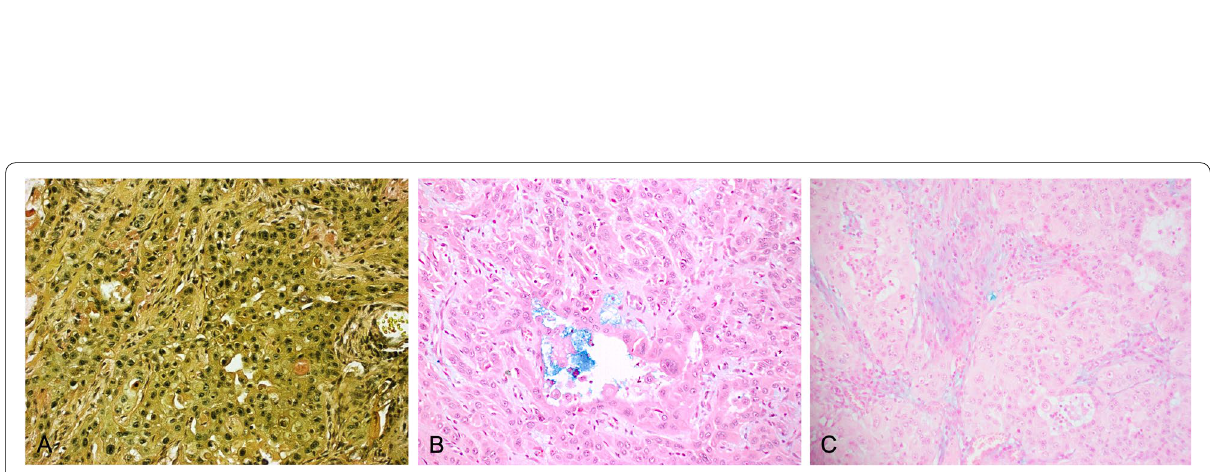
Fig. 2 Special stains . A Mucicarmine highlighting intracellular mucin (400X). B & C Alcian blue highlighting intraluminal and intracellular mucin (400X &